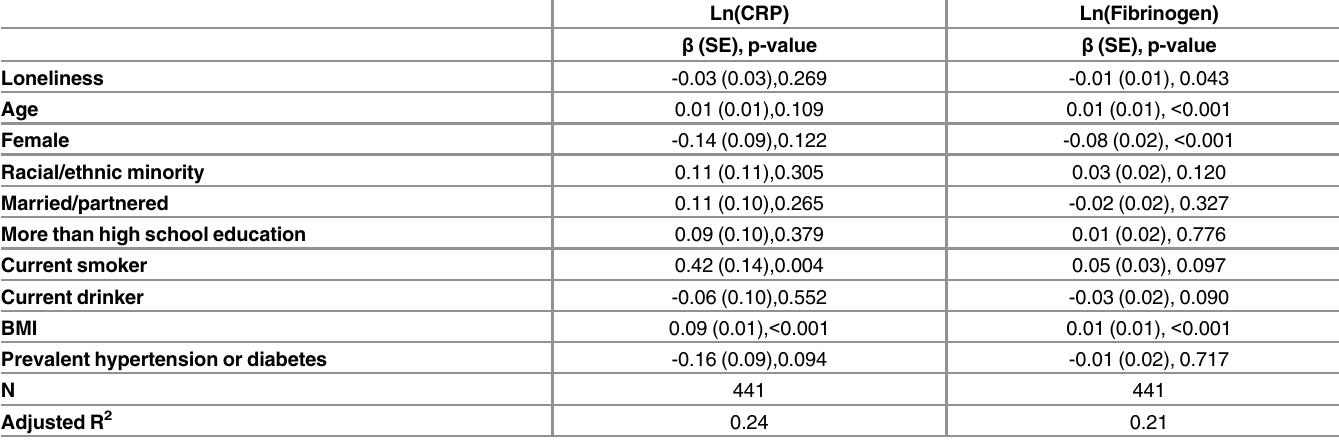
Table 2. Association between loneliness and inflammatory markers.